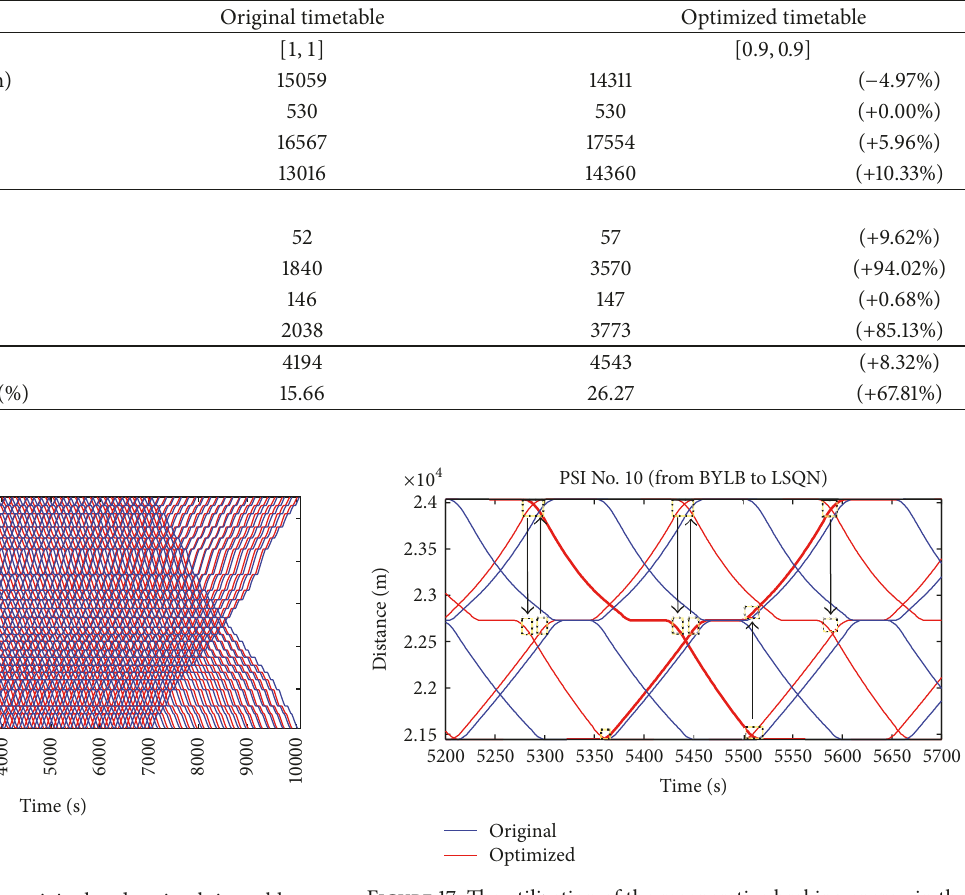
Figure 16: Comparison of the original and optimal timetable. Figure 17: The utilization of the regenerative braking energy in the same power supply